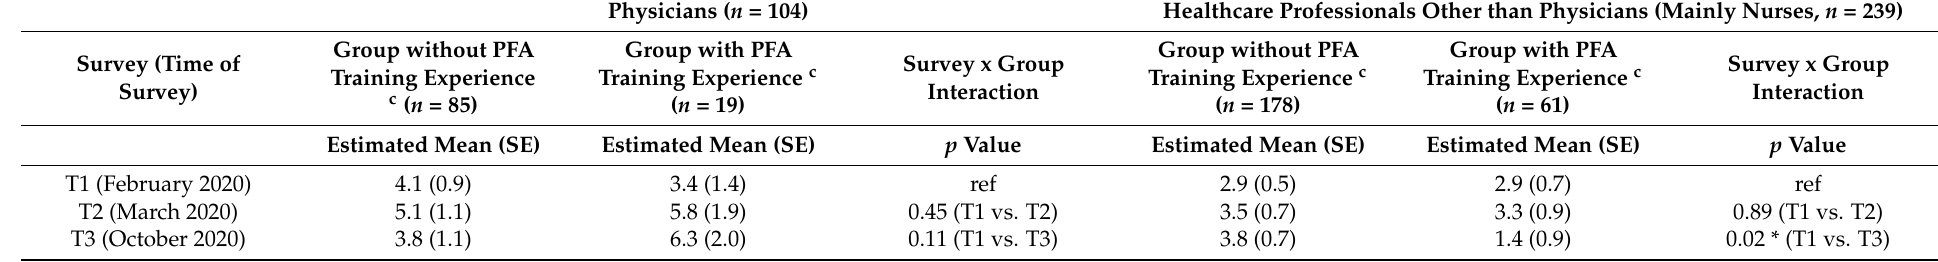
Table 3. The adjusted estimated mean of psychological distress a at baseline (T1), T2, and T3 during the COVID-19 pandemic among a cohort of Japanese healthcare professionals: the mixed model with repeated measures (N = 343 b